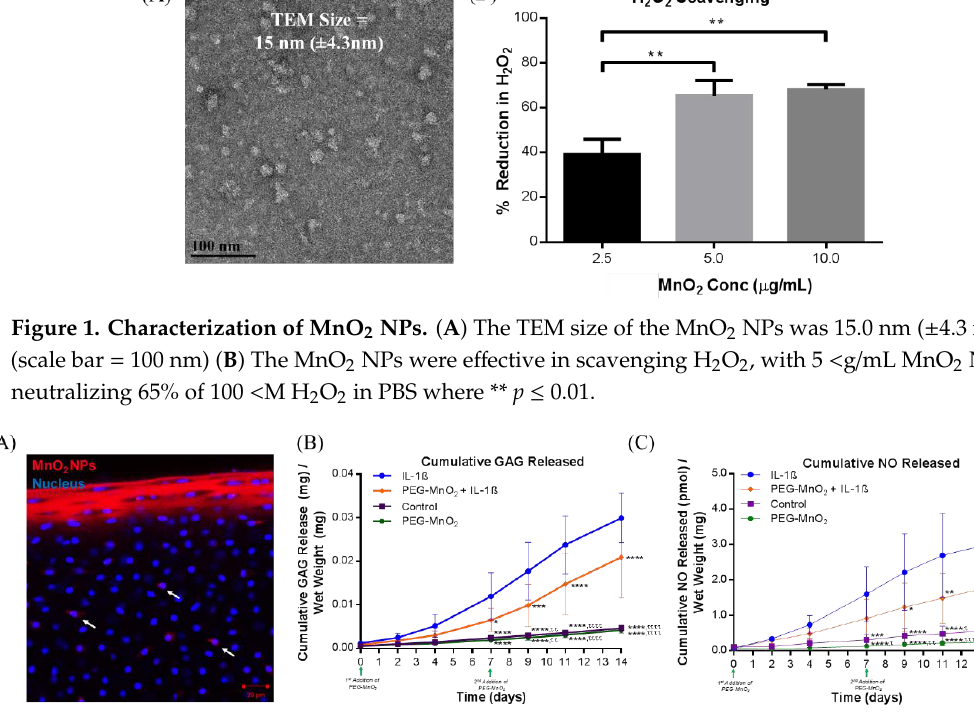
Figure 2. Uptake and Chondroprotection of MnO 2 NPs with cartilage explants. ( A ) Alexa 594 labelled MnO 2 NPs penetrated through cartilage biopsies, with endocytosis by resident